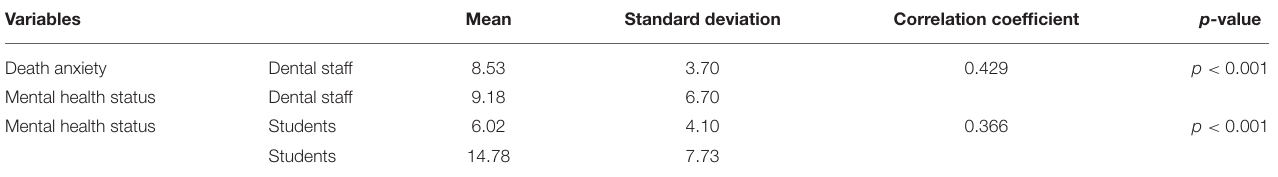
TABLE 2 | Mean scores and correlation coefficient between death anxiety and mental health status in students and dental